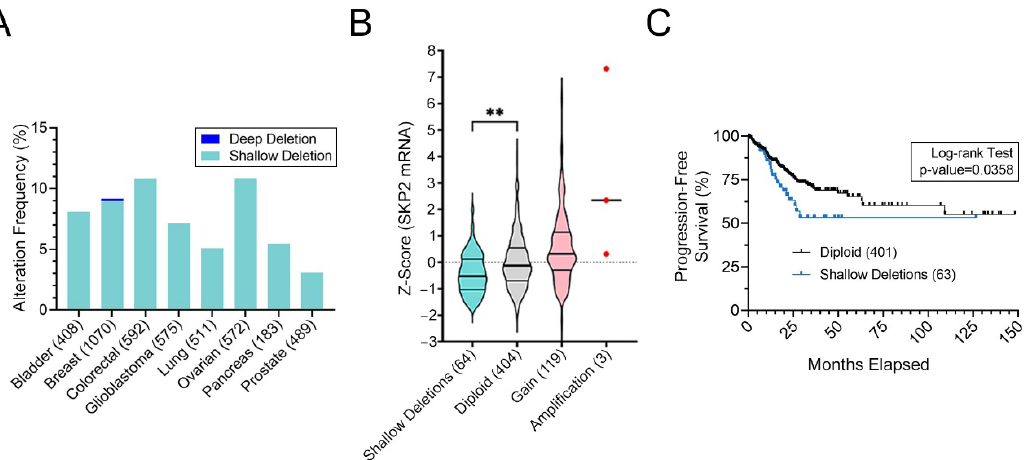
Figure 2. SKP2 Copy Number Losses are Frequent in Cancer and are Associated with Reduced Expression and Worse Progression-Free Survival in CRC. ( A ) Bar graph presenting the frequency of SKP2 copy number losses (deep [homozygous] and shallow [heterozygous] deletions) in eight common cancer types (total cases) [29–31] . Note that shallow deletions occur in 10.8% of CRC cases. ( B ) Violin plots reveal that SKP2 shallow deletions in CRC correspond with significant decreases in expression (mRNA) relative to diploid controls (MW test; **, p -value < 0.01) [29-31] . Horizontal lines identify the 25th, 50th, and 75th percentiles, while the total number of cases in each category is indicated within brackets. ( C ) CRC patients with SKP2 shallow deletions (blue) have significantly worse progression-free survival relative to patients with diploid copy numbers (black) (Log-rank test; p -value ≤ 0.05) [29–31] .